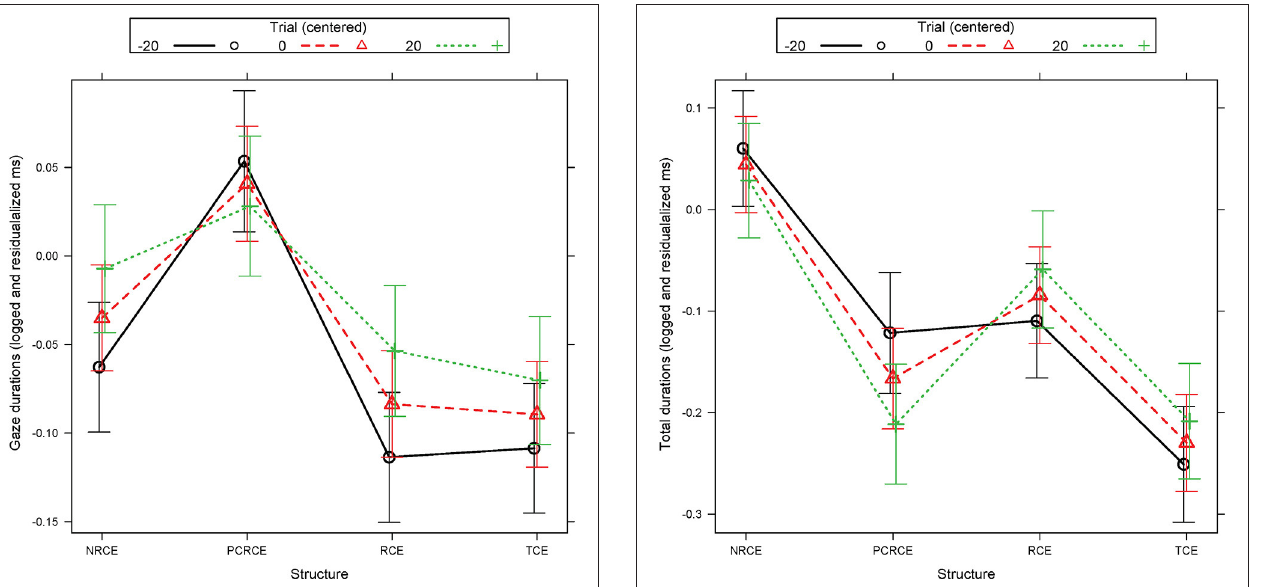
FIGURE 3 | Experiment 1 R01 estimated total durations (logged and residualalized ms): Structure by Trial interaction. Error bars represent the 95% confidence interval (CI) of the